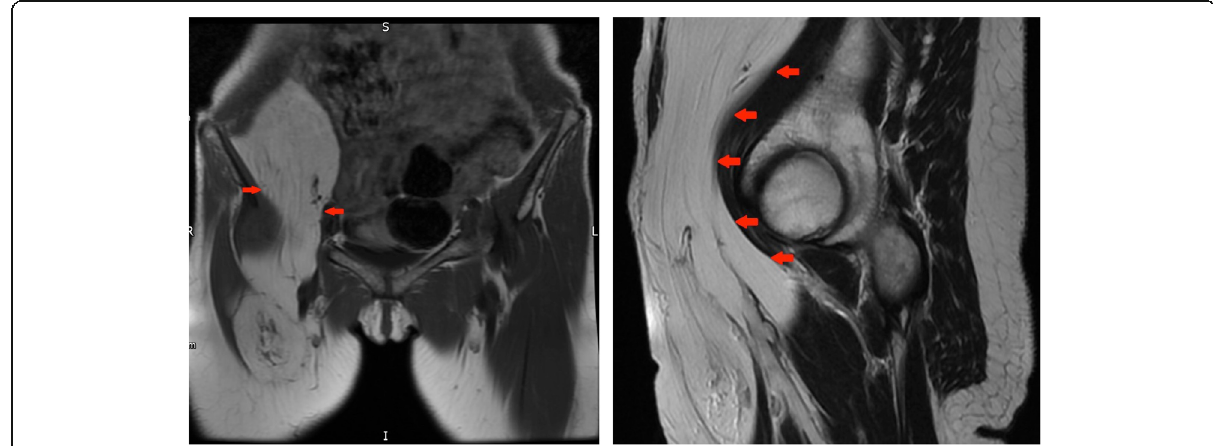
Fig. 16 Left panel: Coronal T1-weighted MR image of the pelvis: large lipomatous tumour in the right iliopsoas compartment proved to be a well